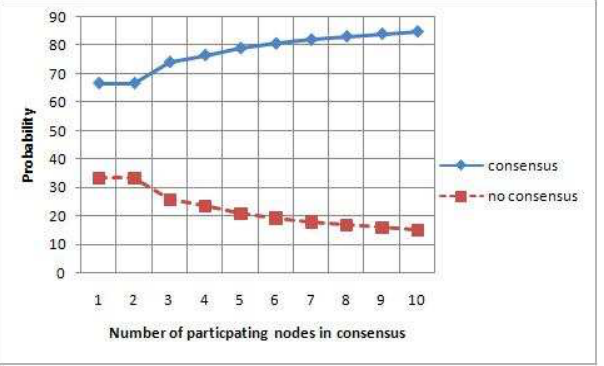
Figure 7. Probability of reaching at consensus and no consensus